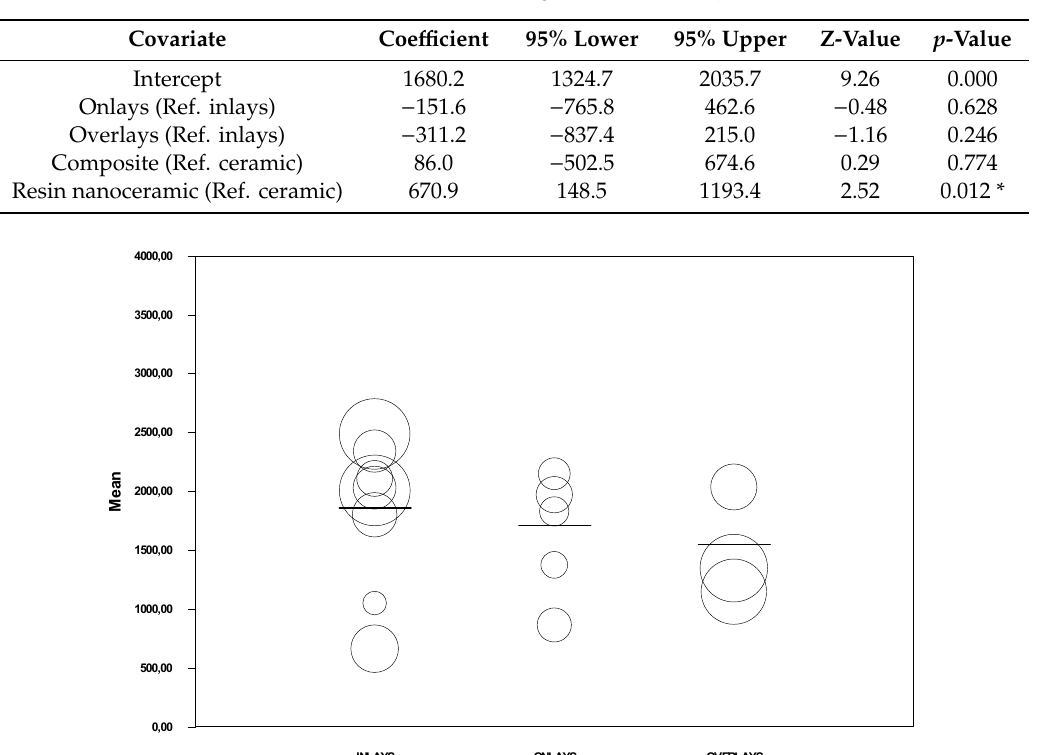
Table 1. Main results of meta-regression model. * p < 0.05.